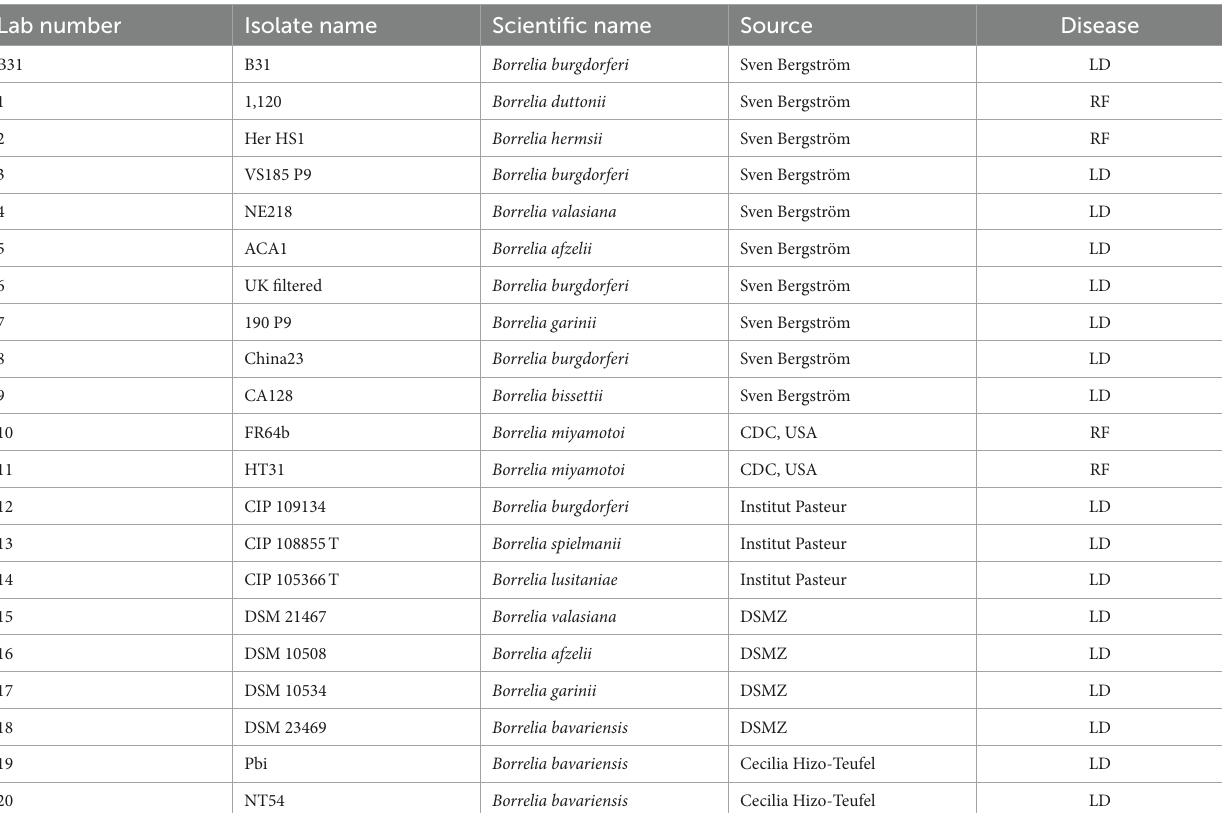
TABLE 1 Borrelia strains used in this